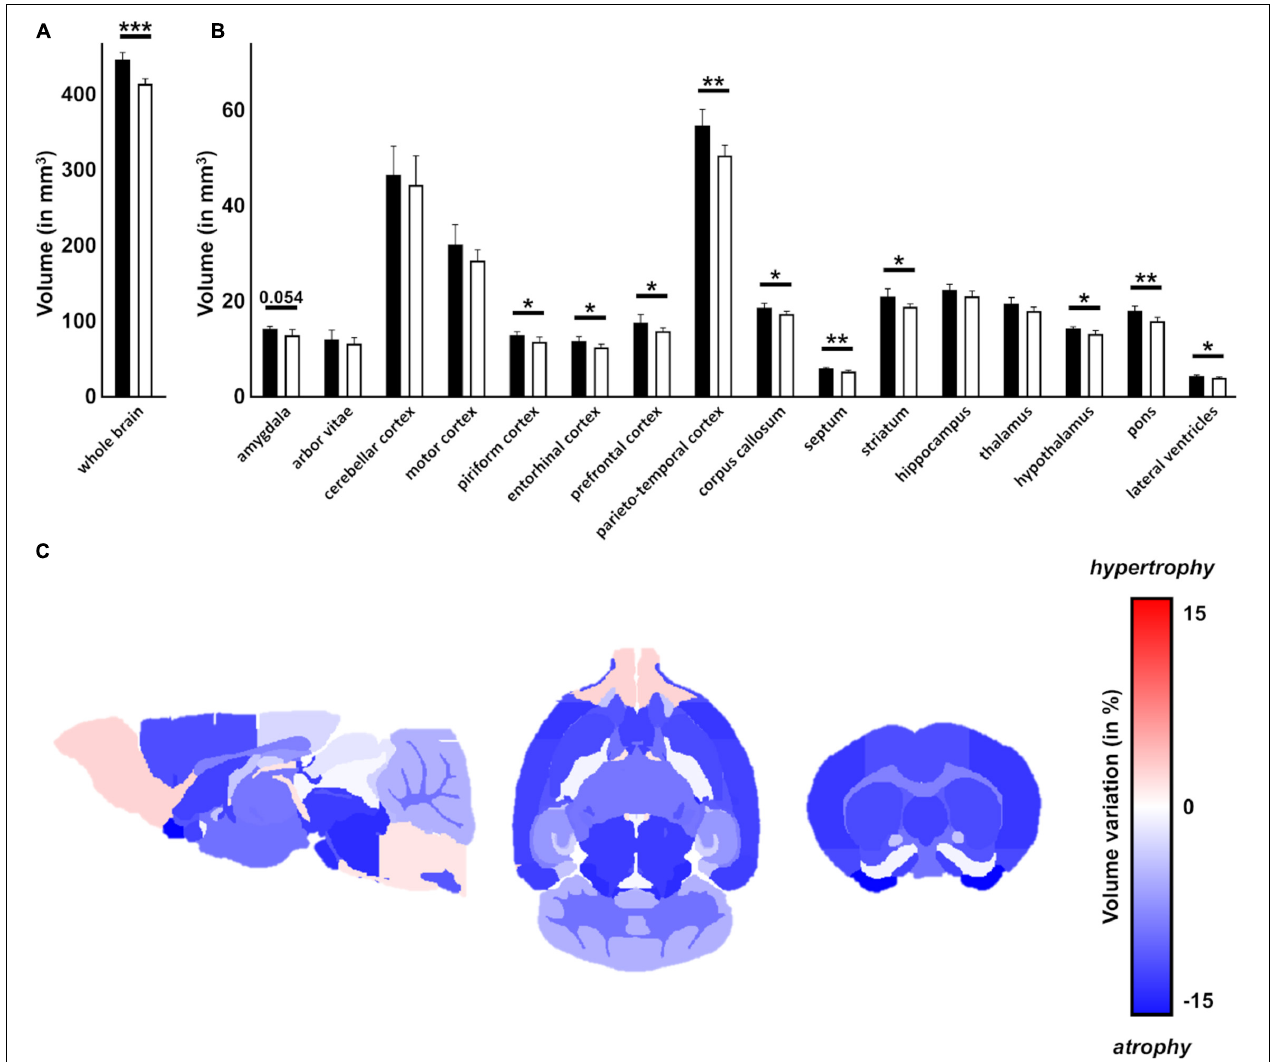
FIGURE 2 | Atrophy of multiple regions including white matter in the Ki91 SCA3/MJD brain. MRI image segmentation was used to measure whole brain volume ex vivo of 18-month-old Ki91 and WT mice ( n = 6 per genotype) and revealed significant global atrophy (–7%, p < 0.001) (A) and reduction of volume of many regions, such as parieto-temporal cortex (–11%, p < 0.01), entorhinal, piriform and motor cortexes (–11% each, p < 0.05), corpus callosum (–7,5%, p < 0.05), striatum (–11%, p < 0.05), septum (–11%, p < 0.01), pons (–12%, p < 0.01) and hypothalamus (–8%, p < 0.05) (B) . Schematic representation of brain regions atrophy in Ki91 mice (C) . Atrophy of many brain regions might suggest impaired connections between those structures. The gradient of red color is for hypertrophy, the gradient of blue color for the atrophy. Two-sample t -test (* p < 0.05, ** p < 0.01, *** p < 0.001), error bars: SEM.